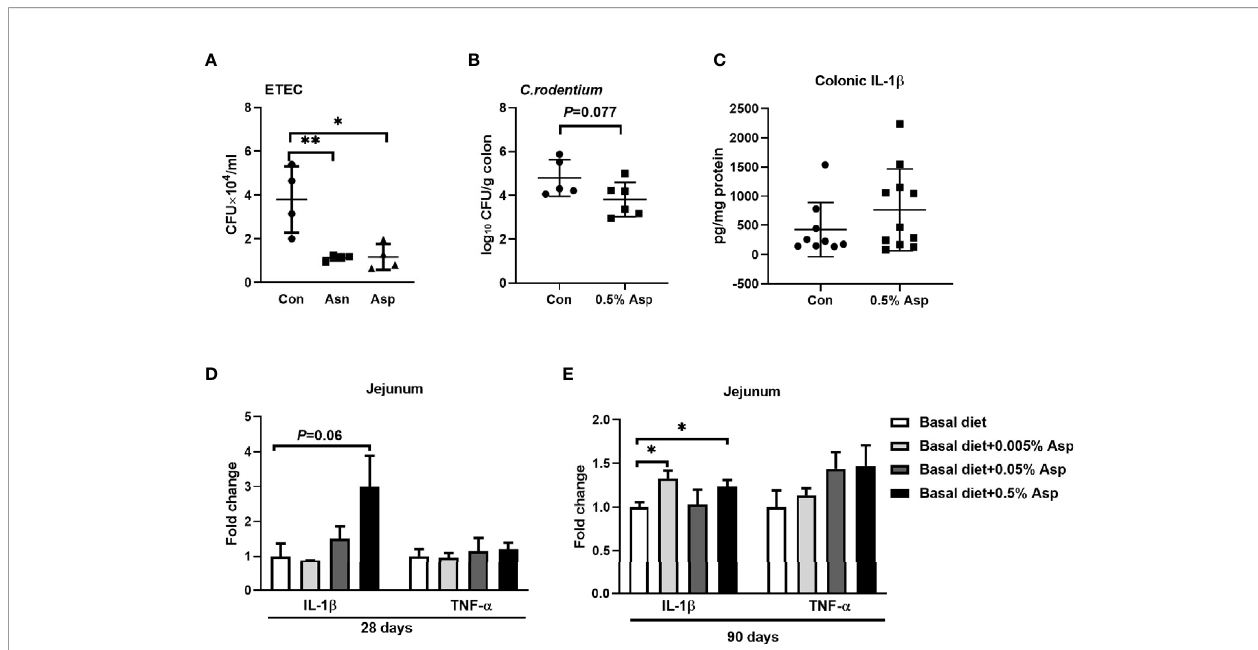
FIGURE 6 | Aspartate affects the immune responses in mice and piglets. (A) Phagocytosis in macrophages ( n = 3 – 4). (B) The Citrobacter rodentium count in the colon from control mice and mice with 0.5% aspartate supplementation ( n = 5 – 6). (C) Interleukin 1 b (IL-1 b ) levels in the colon from control mice and mice with 0.5% aspartate supplementation ( n = 8 – 11). (D) mRNA expressions of IL-1 b and tumor necrosis factor alpha (TNF- a ) in the jejunum from control piglets and piglets given aspartate for 28 days ( n = 4 – 5). (E) mRNA expressions of IL-1 b and TNF- a in the jejunum from control piglets and piglets with aspartate supplementation for 90 days ( n = 5 – 6). Data were analyzed with unpaired t -test (A – C) or with one-way ANOVA (D, E) . Error bars represent the mean ± SEM. * p ≤ 0.05, ** p ≤